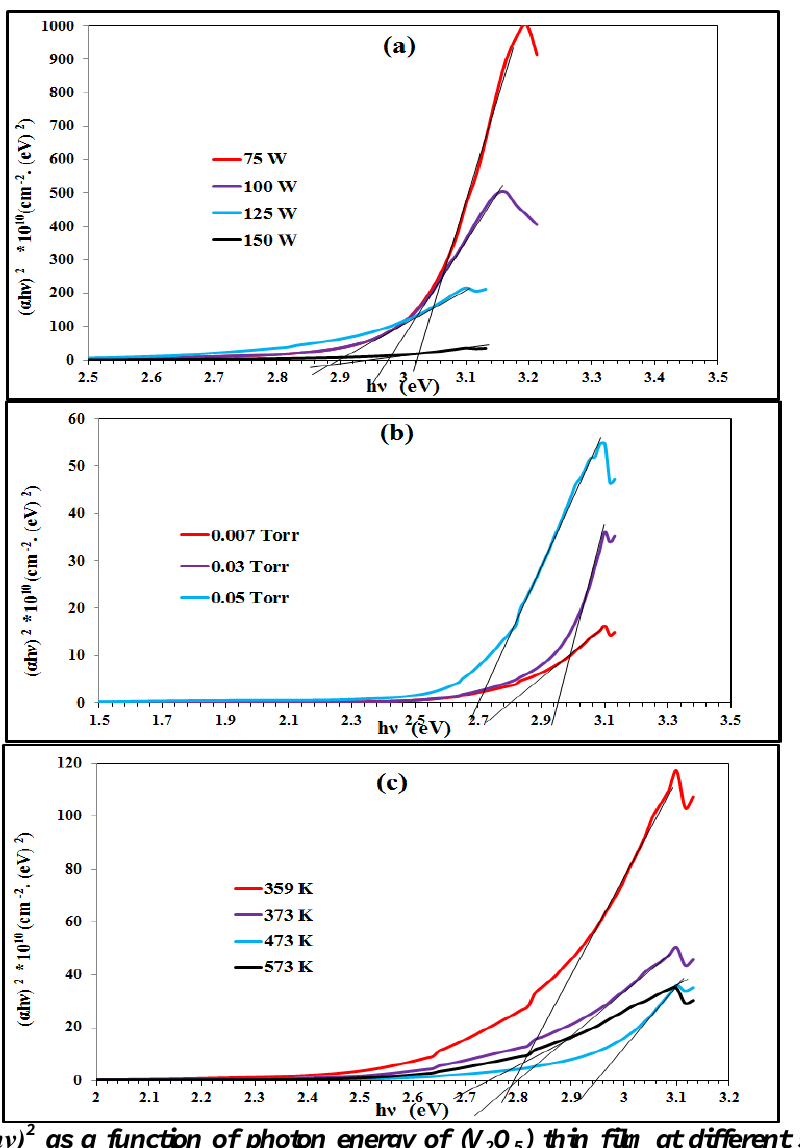
O ) thin film at different sputtering 2 5